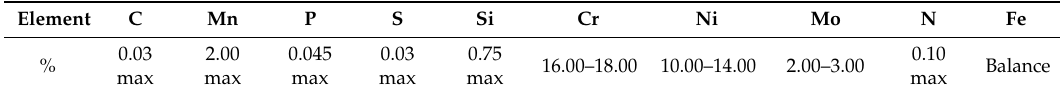
Table 1. Chemical composition of SS316L.